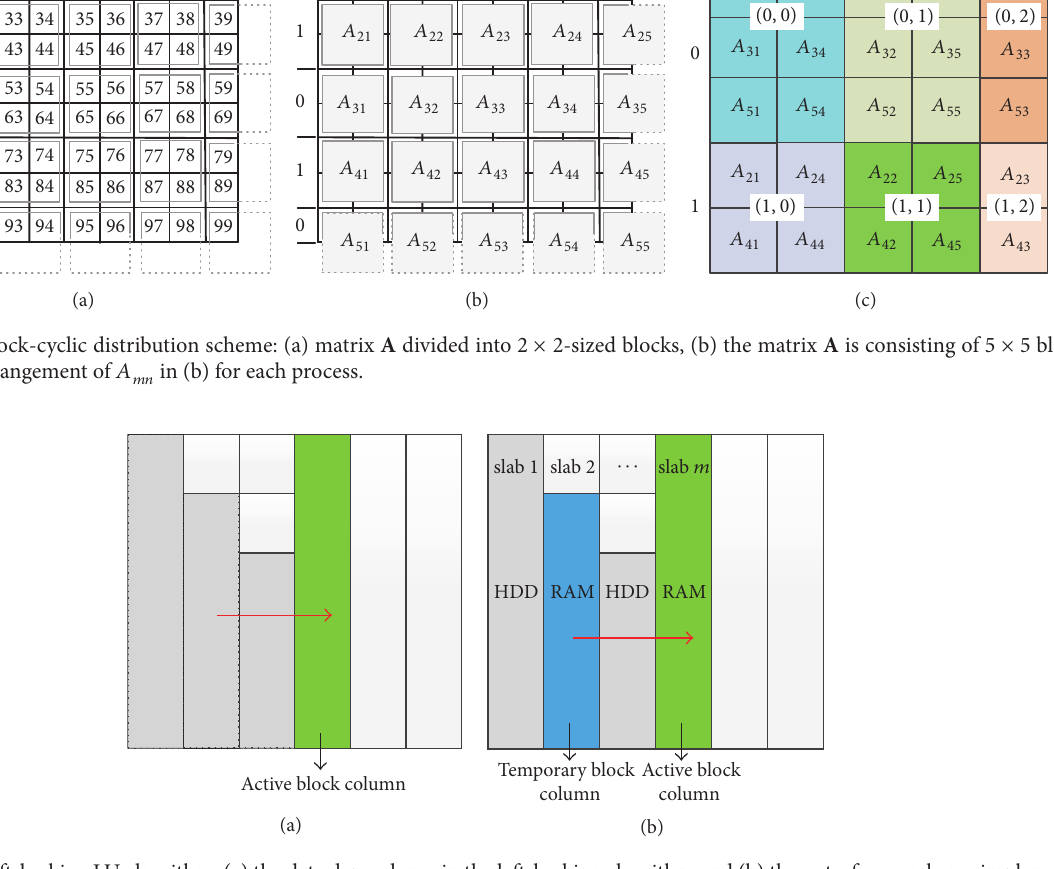
Figure 4: The left-looking LU algorithm: (a) the data dependence in the left-looking algorithm and (b) the out-of-core scheme implemented slab by slab.